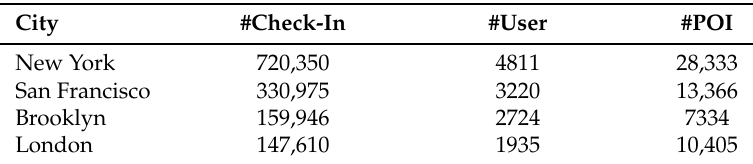
Table 1. Statistics of the data of each